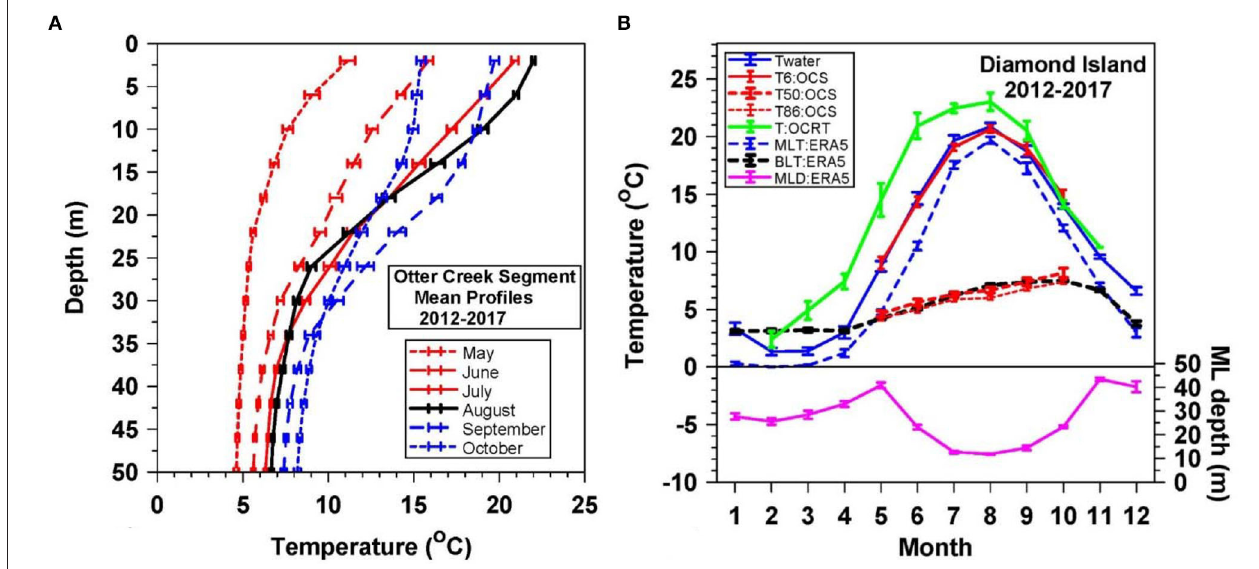
FIGURE 4 | (A) Mean monthly temperature profiles with depth for Otter Creek Segment and (B) seasonal cycle of ERA5ML depth, ERA5 water temperatures and different observations at different depths.